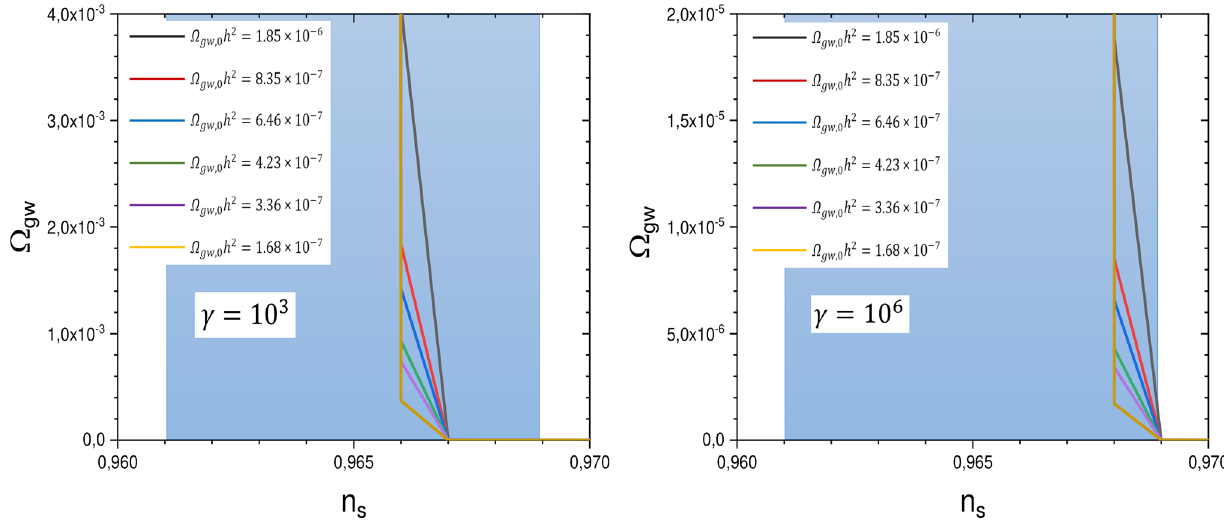
Ω 2 = 8 . 35 × 10 − 7 , blue line corresponds to Ω 2 = 6 . 46 g w, 0 h g w, 0 h × 10 − 7 , green line corresponds to Ω 2 = 4 . 23 × 10 − 7 , purple line g w, 0 h corresponds to Ω g w, 0 h 2 = 3 . 36 × 10 − 7 , and yellow line corresponds to Ω g w, 0 h 2 = 1 . 68 × 10 −